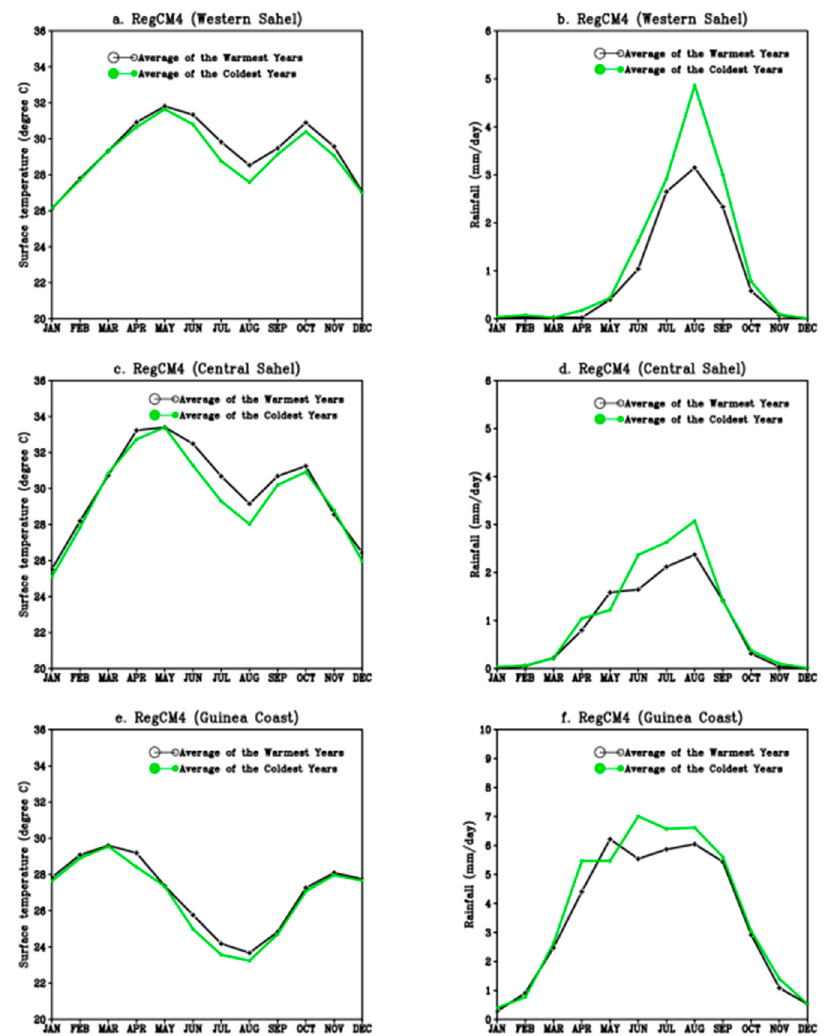
Figure 4. Annual cycle of monthly surface temperature (left) and precipitation (right) from RegCM4 model averaged over: ( a , b ) the western Sahel, ( c , d ) the central Sahel and ( e , f ) the Guinea coast for the averages of the warmest years and the coldest years.